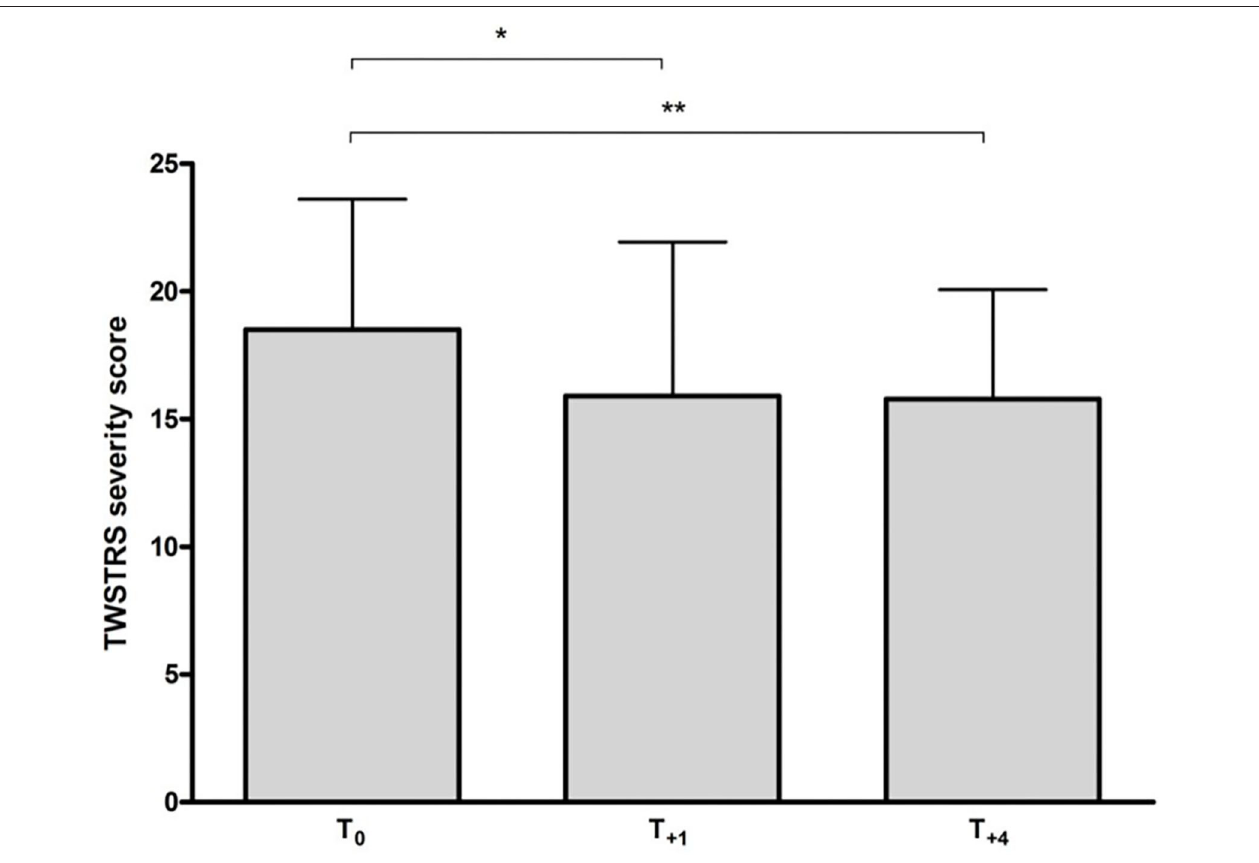
FIGURE 2 | Mean ( + SD ) TWSTRS severity subscore at baseline and following incoBoNT/A injections. * p < 0.05; ** p < 0.01. T0 = mean baseline TWSTRS just before first incoBoNT/A treatment; T + 1 = mean TWSTRS after 12 weeks just before second incoBoNT/A treatment; T + 4 = mean TWSTRS 12 weeks after 4th incoBoNT/A